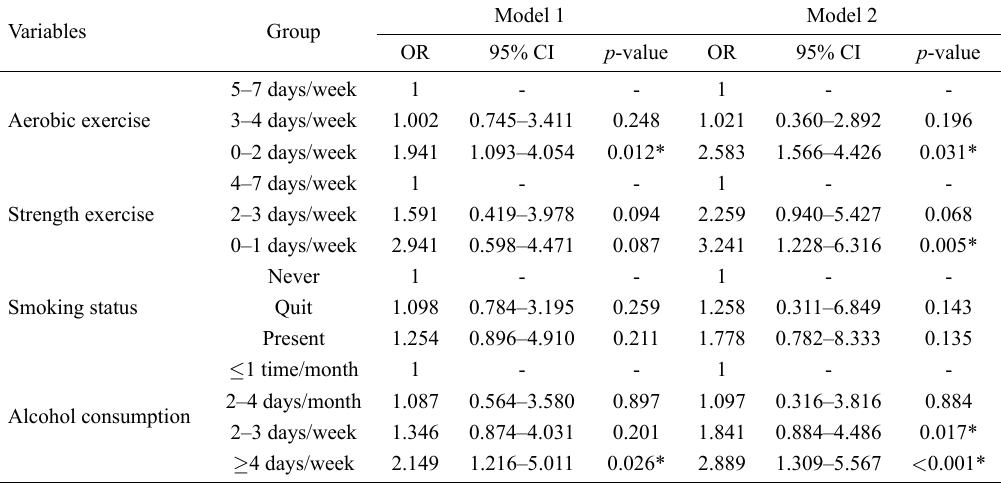
Table 5. Visceral fat obesity prevalence according to exercise type and health related